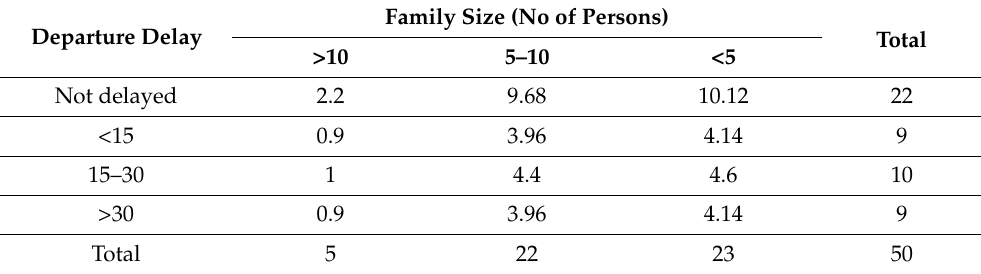
Table 4. Expected frequencies for perfectly independent variables.